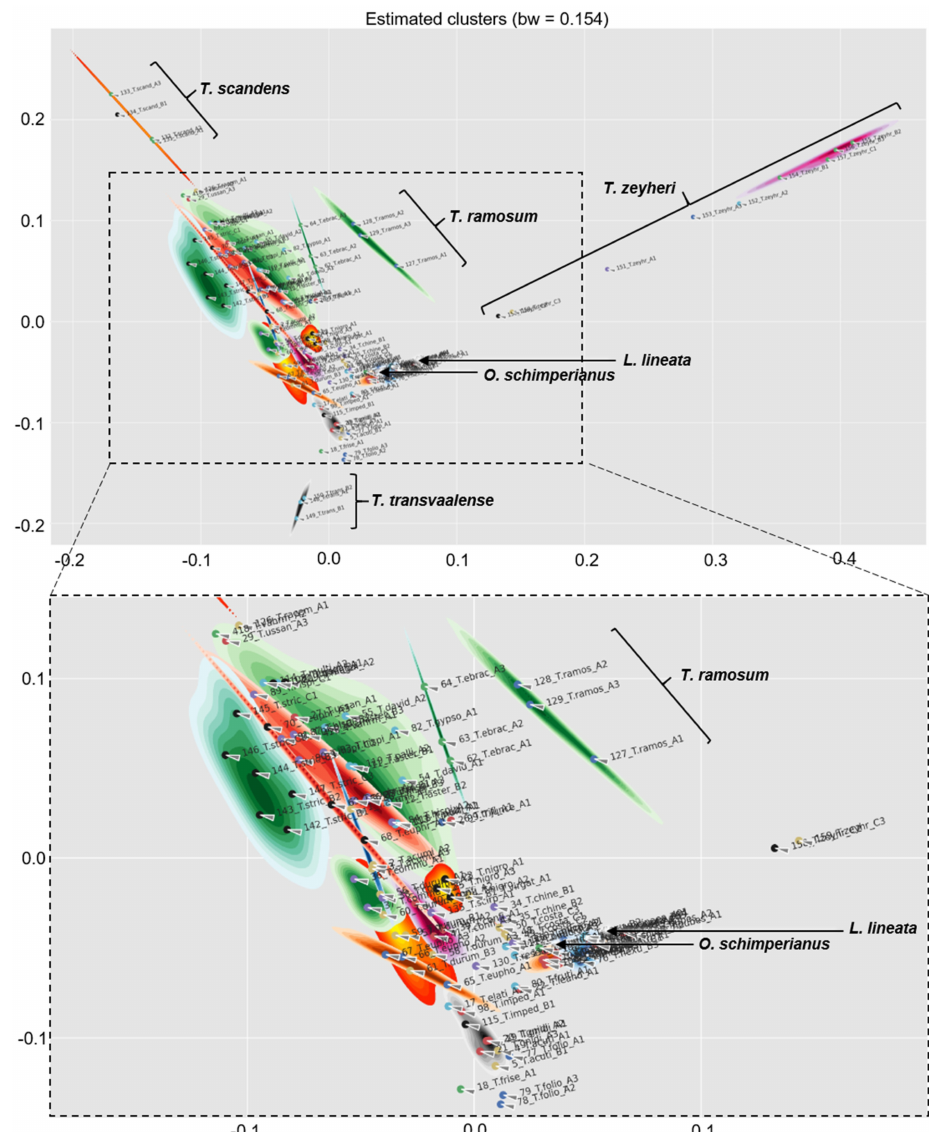
Figure 1. Principal component analysis with cluster map showing the relationships among 46 Thesium species, Lacomucinaea lineata and Osyridicarpos schimperianus , based on phenolic com- pound composition. Clusters are indicated with different colours. Species names corresponding to sample labels are provided in Table